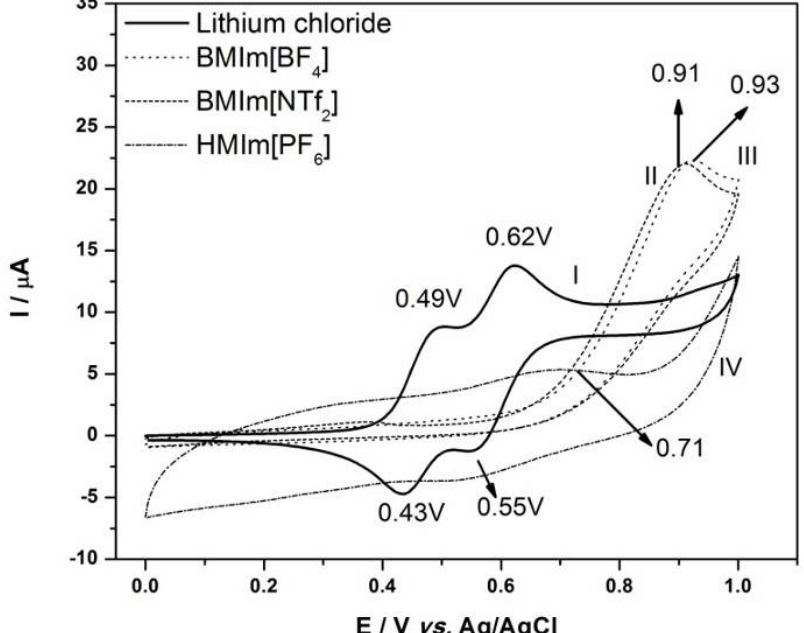
Figure 1. Cyclic voltammogram obtained for oxidation of 244 mg·L − 1 of o -dianisidine in 4.2 g·L − 1 of LiCl (I); o -dianisidine in 12.6 mg·L − 1 of BMIm[NTf 6.78 mg·L − 1 BMIm[BF ] (III); o -dianisidine in 9.36 mg L − 1 HMIm[PF 4 carbon electrode. Scan speed (  ) = 50 mV·s − 1